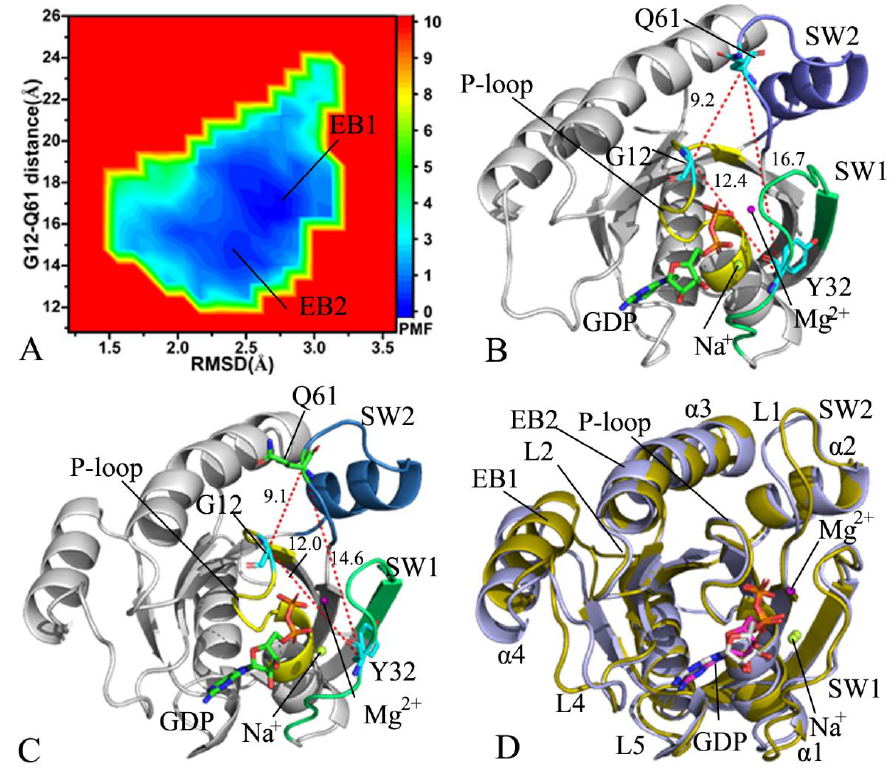
Figure 3. Free energy profiles and structural information of the GDP-bound WT KRAS: ( A ) the FEL built by using the RMSD and the distance of Y32 away from Q61, ( B ) the structure in the EB1, ( C ) the structure in the EB2, and ( D ) superimposition of the structures for KRAS in the EB1 and EB2. The distances are scaled in Å, and the PMF is indicated in